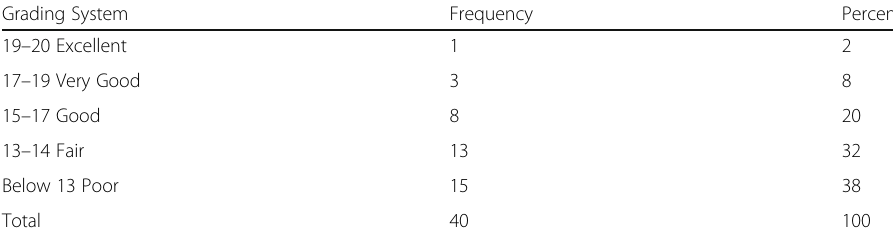
Table 1 Frequency of the participants ’ Listening Test